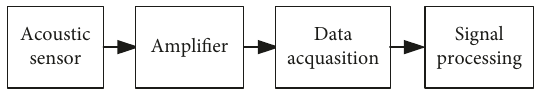
Figure 3: Whole signal processing system.